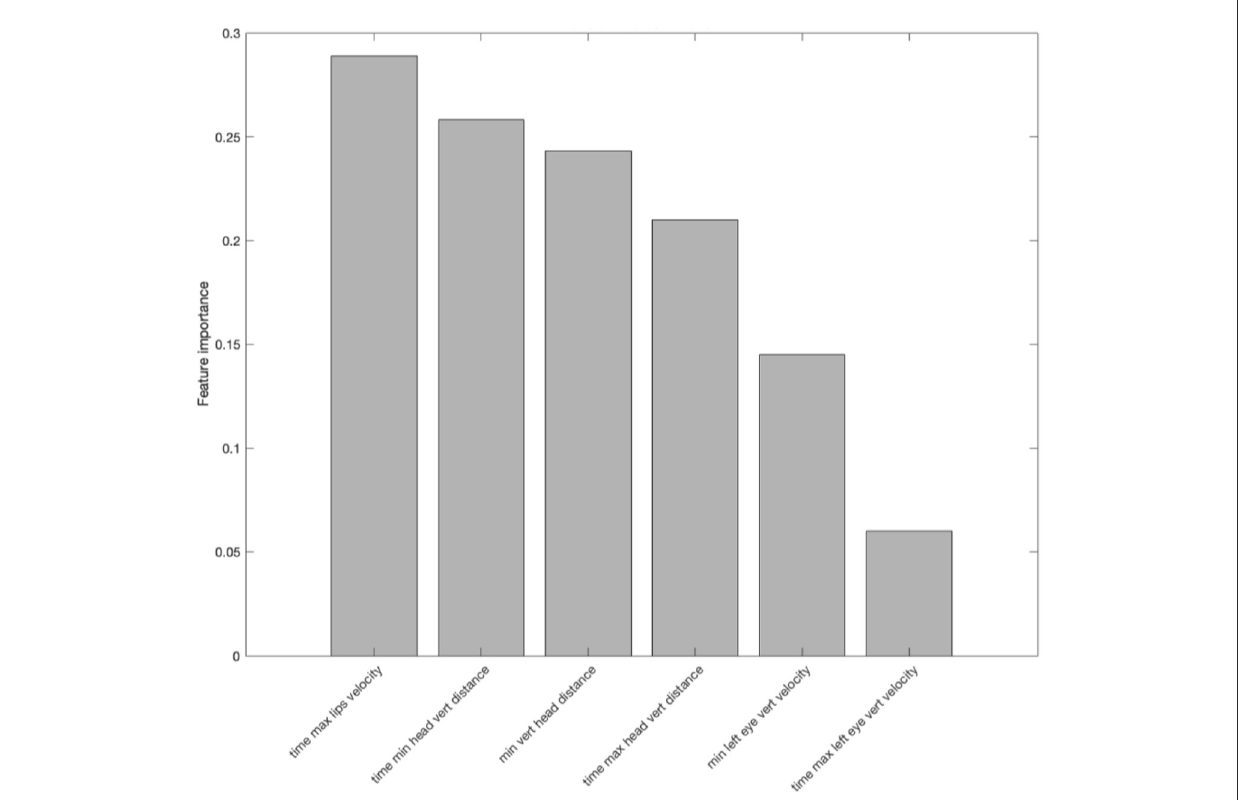
FIGURE4 Important features identified by the random forest analysis in differentiating the two speech styles (clear and plain) in Tone 1. The y-axis shows the feature importance measured by the random forest. The feature importance measures the increase in classification error if the values of the feature are permuted. The greater the error the higher the importance of the feature